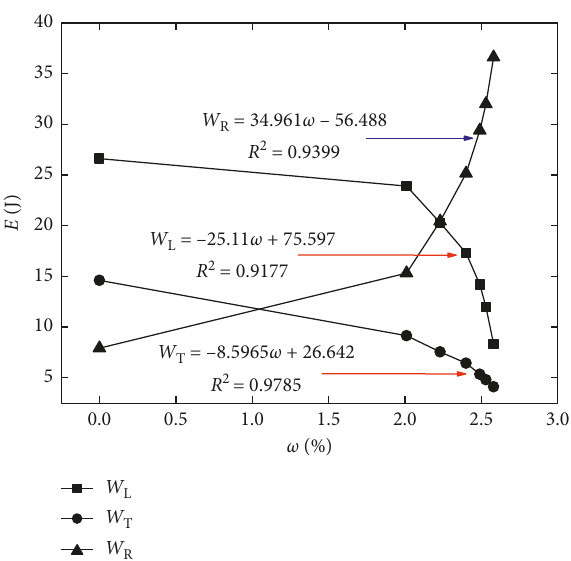
Figure 11: Variation curve of each type of energy in the system with moisture